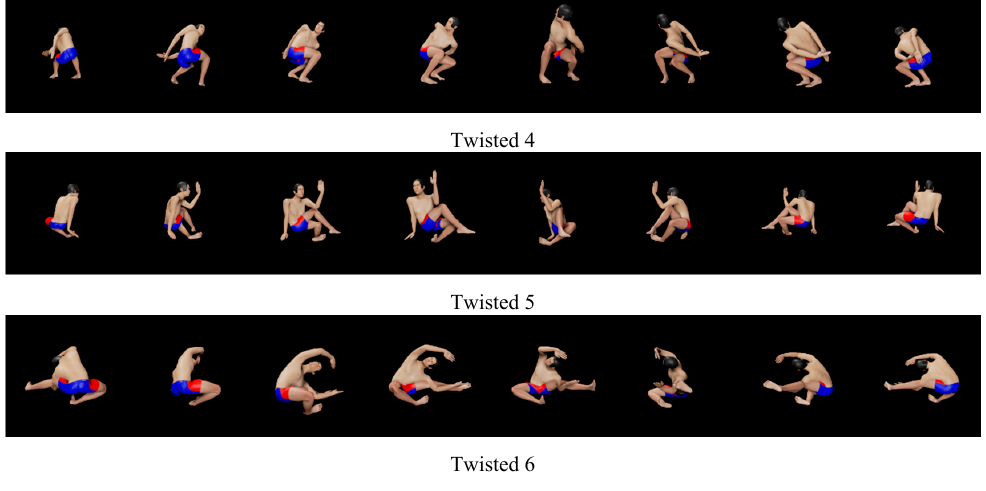
Figure 5. Six twisted poses.